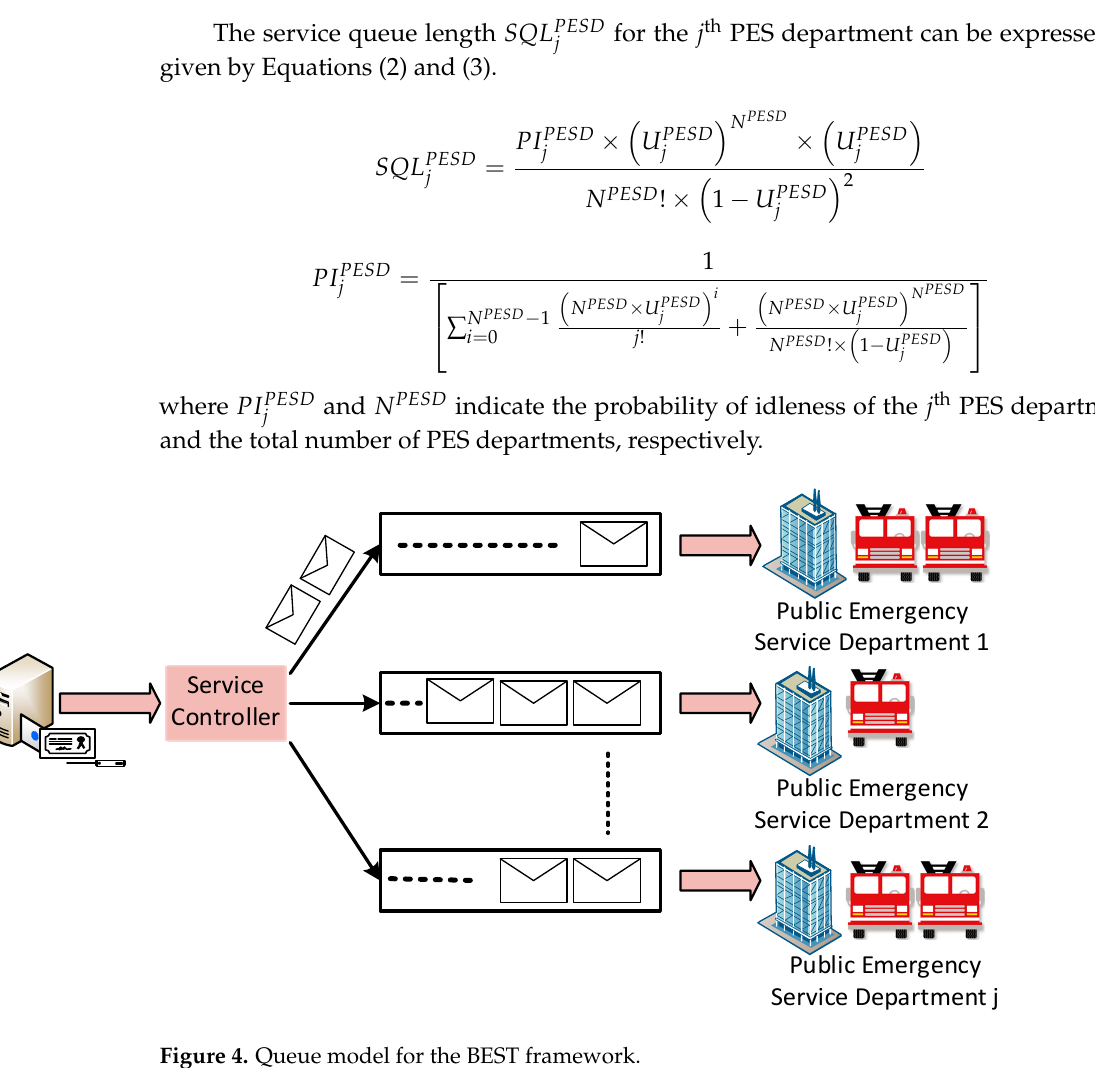
Figure 4. Queue model for the BEST framework.